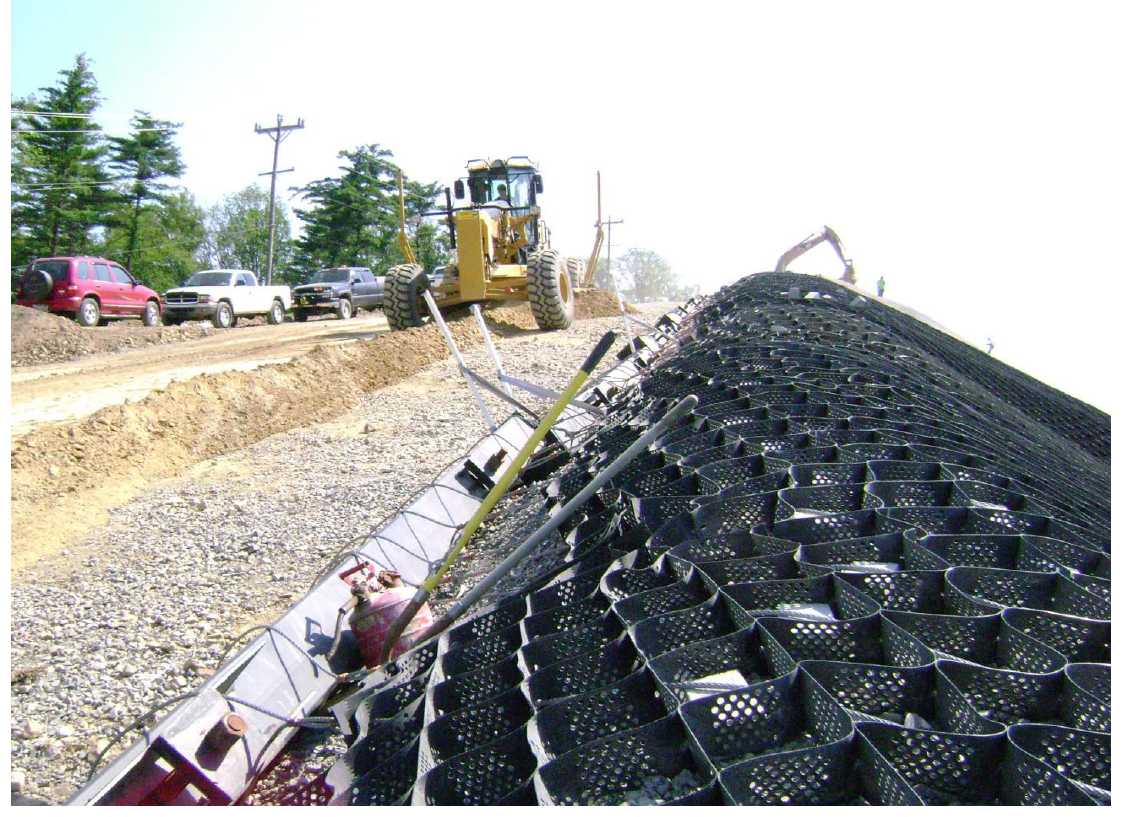
Figure 15. Typical view of anchor beam installation. Tendon-supported geocell panels are visible to the right. Hollow-section structural steel beams with ground anchor rods and bearing plates are visible to the